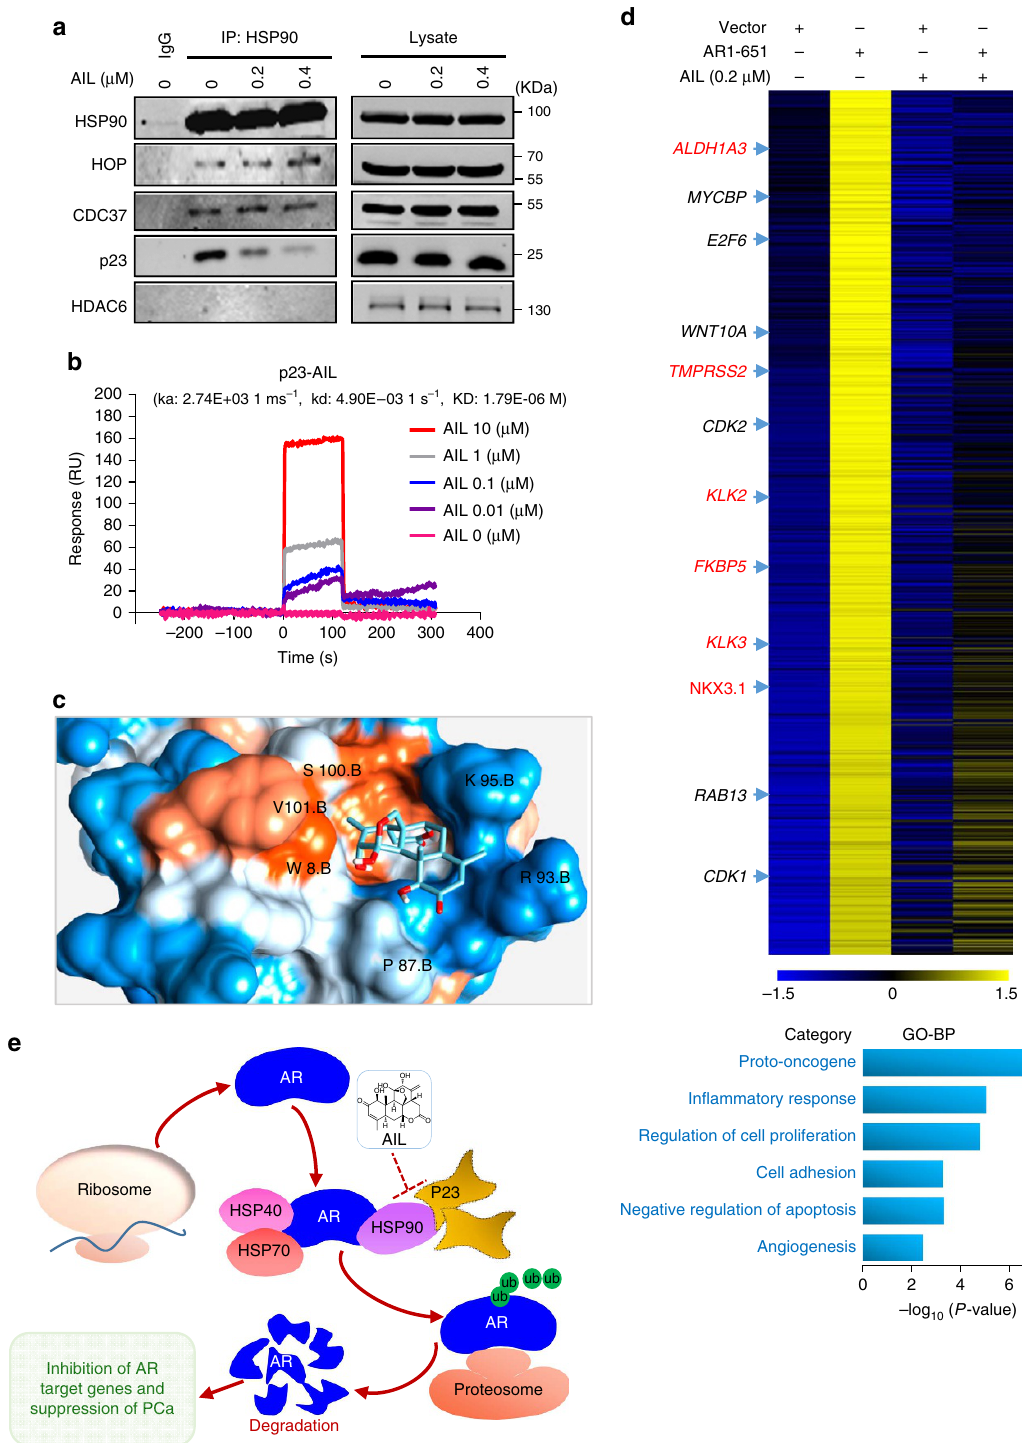
Figure 5 | Interaction of AIL with p23 protein in vitro . ( a ) 22RV1 cells were treated with or without 1 m M AIL for 12h. Anti-HSP90 IP was done and co-immunoprecipitated proteins were detected using indicated antibodies. ( b ) The interaction between p23 protein and AIL was measured by ProteOn XPR36. ( c ) Mapping AIL binding site on p23. ( d ) Top: expression level heatmap (log2 based) of AR 1–651 induced genes which were inhibited by AIL. LNCaP cells were treated as described in Methods and the RNA samples of the indicated groups were sent for RNA-seq. First gene expression values (RPKM) were normalized (z-score transformed) across samples. Then the K-means clustering method was used to portion all genes into the clusters with Pearson correlation as the metric of distance. In the heat map, yellow means ‘higher’ expression and blue means ‘lower’ expression. Refseq IDs were converted into gene symbols listed in Supplementary Data 1. Bottom: Gene Ontology (GO) analysis of the AR 1–651 target genes which inhibited by AIL. ( e ) Schematic illustrating the mechanism of downregulating AR protein level by AIL. When treating with AIL, the interaction of p23 and HSP90 is prevented and the interaction between AR and the molecular-chaperones is decreased, causing ubiquitination of AR. Then, AR is degraded by the proteasome, which reduces the expression of AR target genes and inhibits PCa growth and